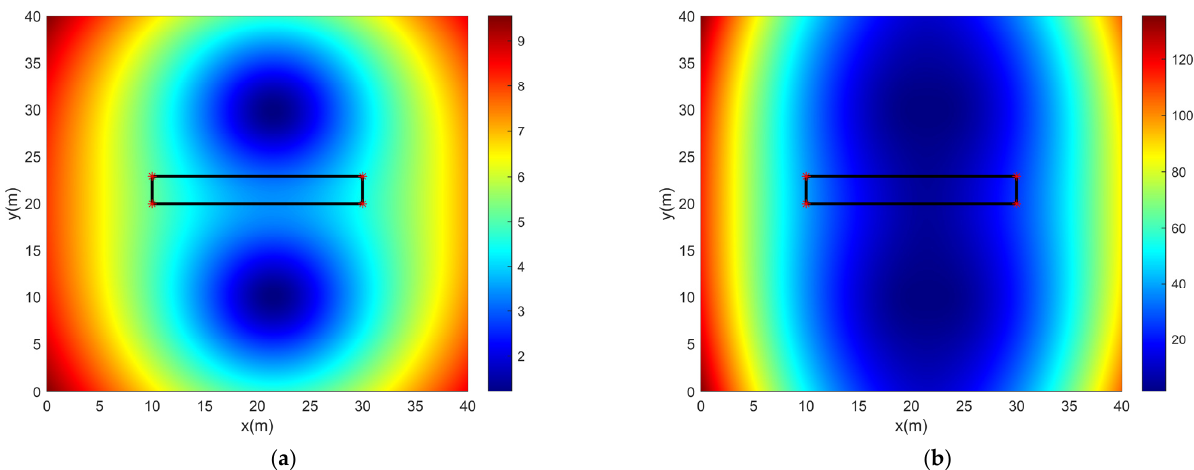
Figure 7. DOP values in passage simulation space: ( a ) HDOP values; ( b ) PDOP values.